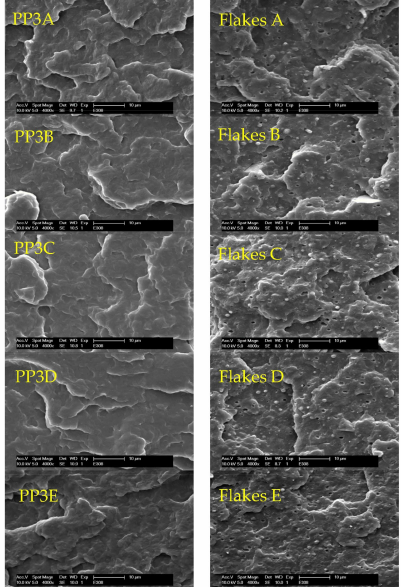
Figure 10. Scanning electron microscope (SEM) images of the virgin material of PP3 and the recycled flakes ( A ) and the blend series on basis of PP2 ( B ), LCB-PP with PODIC C126 ( C ), LCB-PP with PEROXAN LP ( D ), HMS-PP ( E ).